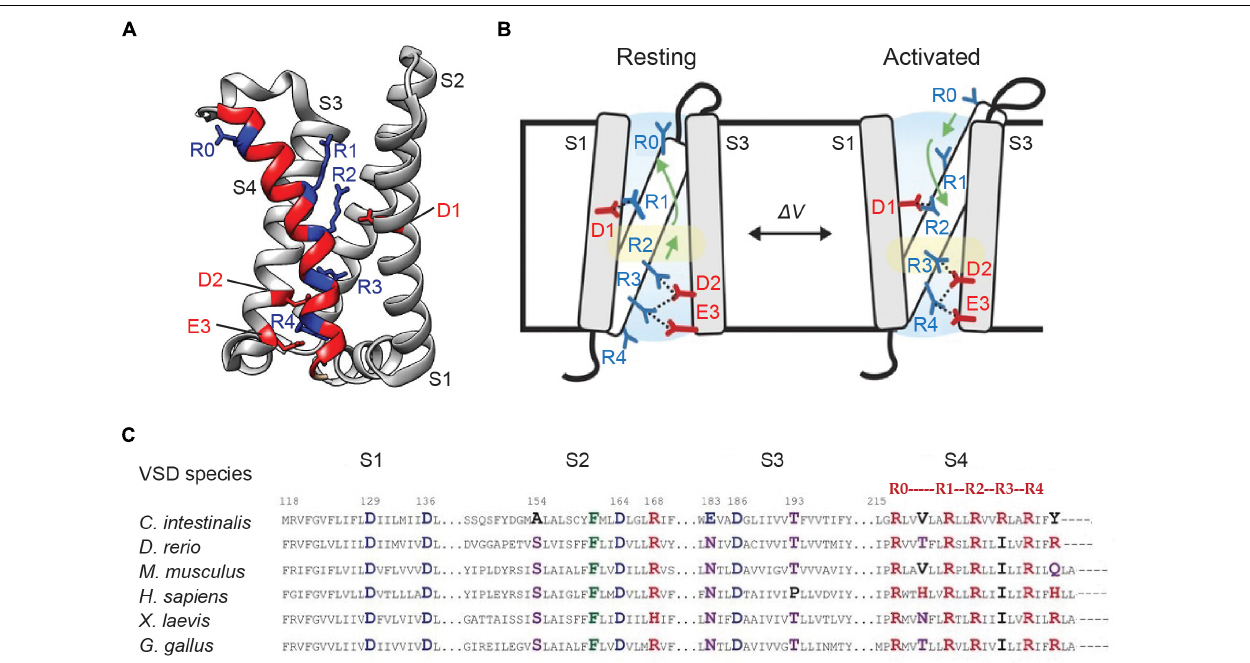
FIGURE 5 | Genetically encoded voltage indicators kinetics and voltage dependence of optical responses largely depend on voltage-sensitive conformational changes in its VSD. (A) Crystal structure of the VSD of Ciona intestinalis voltage sensitive phosphatase (PDB ID 4G7V). The four transmembrane helices S1–S4 are shown. S4 is highlighted in red. The position of the gating arginines R1–R4 (every third amino acid starting at 223) as well as the outermost S4 arginine R0 (position 217 in Ci VSD) are shown in blue. The countercharges D1 (on S2 helix), D2 and E3 (on S3 helix) are indicated in red. (B) A mechanistic model of voltage sensing in Ci VSD. The activated UP state is accompanied by a 5 Å S4 down movement and a ∼ 60 ◦ counterclockwise rotation of the entire helix. The arginines are then stabilized by successive negative countercharges, from R1–D1, R2–D2, and R3–D3 pairings in the resting or DOWN state to R2–D1, R3–D2, and R4–E3 in the UP configuration. (C) Sequence alignment of the VSD transmembrane segments of voltage sensitive phosphatase orthologs. Positive, negative and polar residues are indicated in red, blue, and purple, respectively. The numbering follows that of the Ciona homolog (Li et al., 2014; Piao et al., 2015).